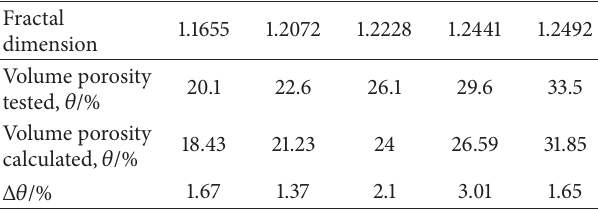
Table 2: Volume porosity of porous metal materials made by irregular powder with the particle size of 74 ∼ 150 𝜇